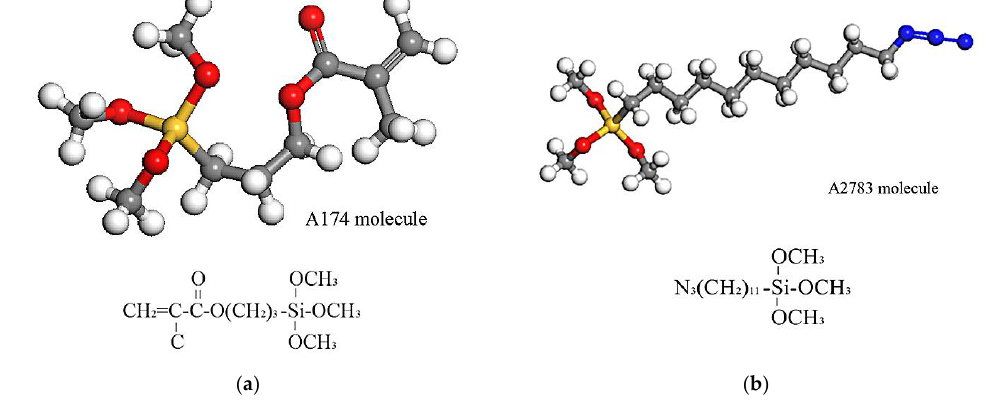
Figure 2. The chemical structure of ( a ) A174; and ( b ) A2783.